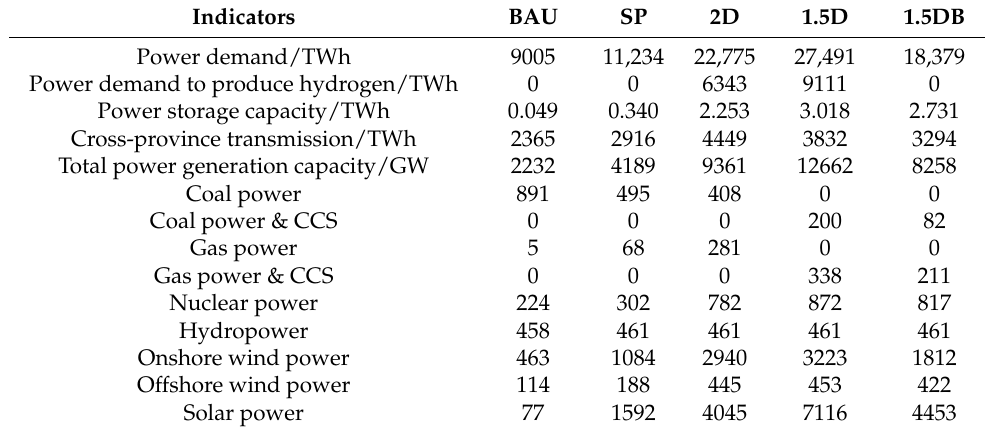
Table 7. Power system planning indicators in